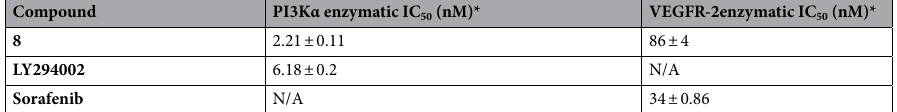
Table 3. IC 50 values of compound 8 against PI3Kα and VEGFR-2. N/A not applied. *Mean activity values of triplicate results.